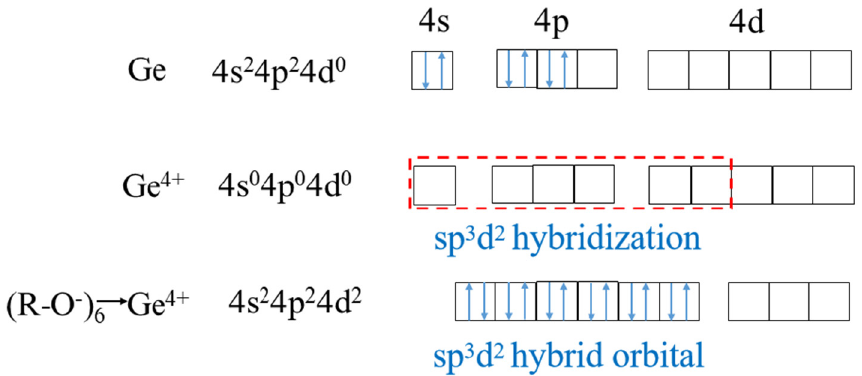
Figure 12. Schematic diagram of molecular orbital.